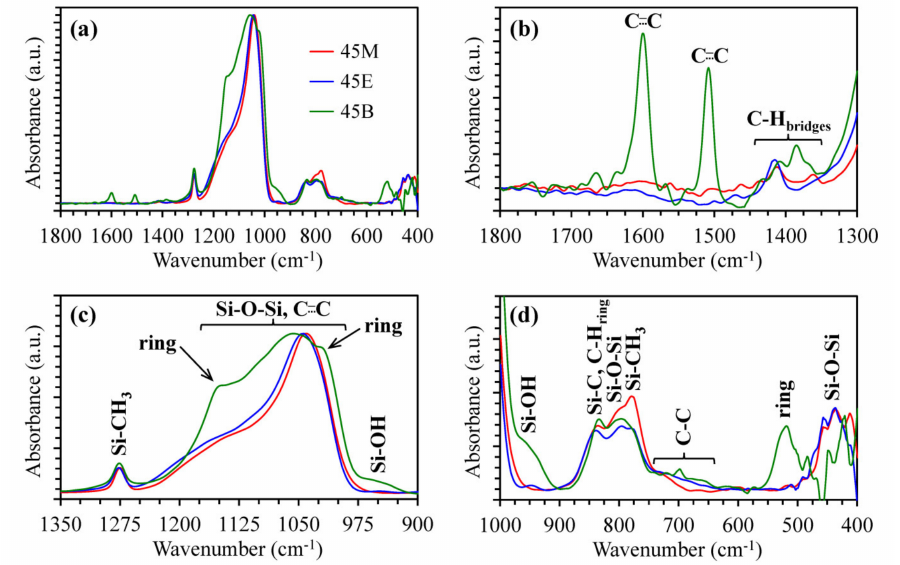
Figure 3. Entire fingerprint region ( a ) and its local ranges ( b – d ) of FTIR spectra of hard baked (at 430 ◦ C in air) periodic mesoporous organosilicate films with di ff erent